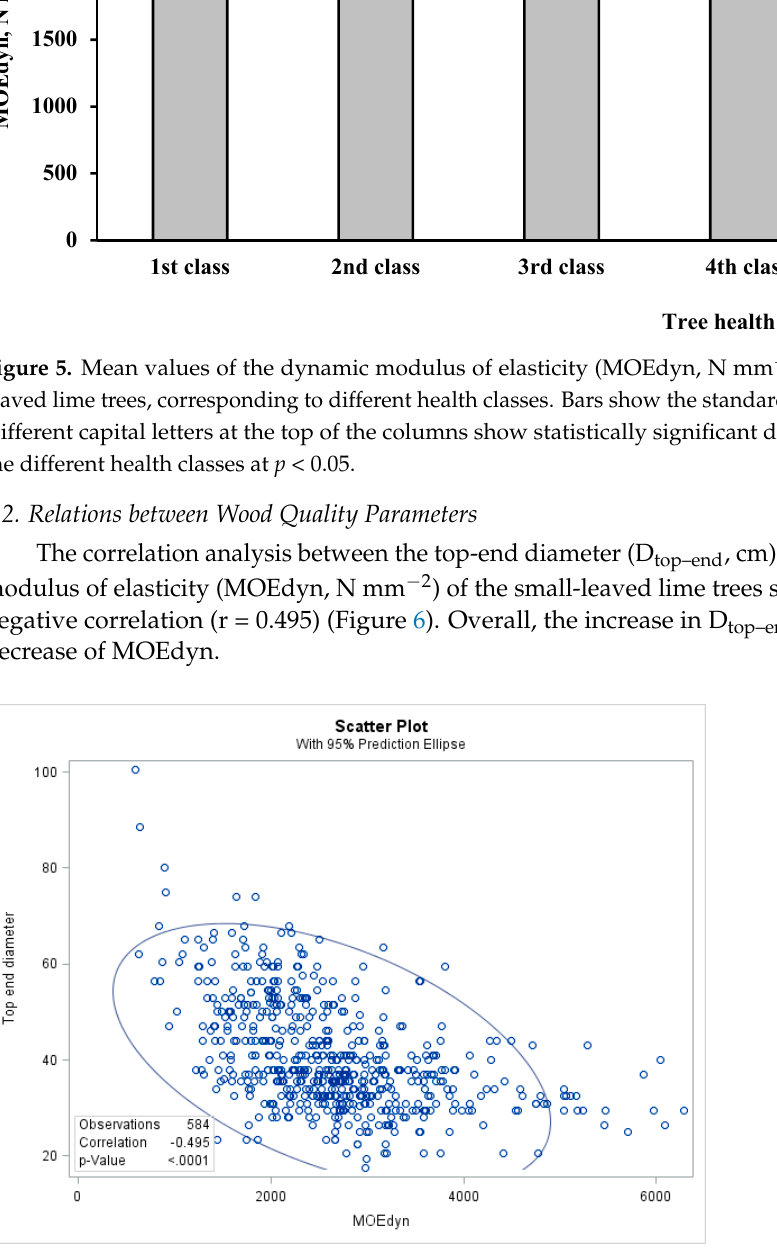
Figure 6. Correlation between top-end diameter (D top–end , cm), and the dynamic modulus of elasticity (MOEdyn, N mm − 2 ) of small-leaved lime trees in urban sites (analysis included all data, n = 584). To identify differences between the sites, the data were analyzed separately for trees growing along urban streets, in the urban park, and in the forest (Figure 7). The best correlation (r = 0.588) between the D top–end and the MOEdyn of the small-leaved lime trees was obtained for trees in the forest sites. For the trees in the urban park, this correlation was relatively weak (r = 0.357). The weakest correlation (r = 0.290) was obtained for the small-leaved lime trees growing along the urban